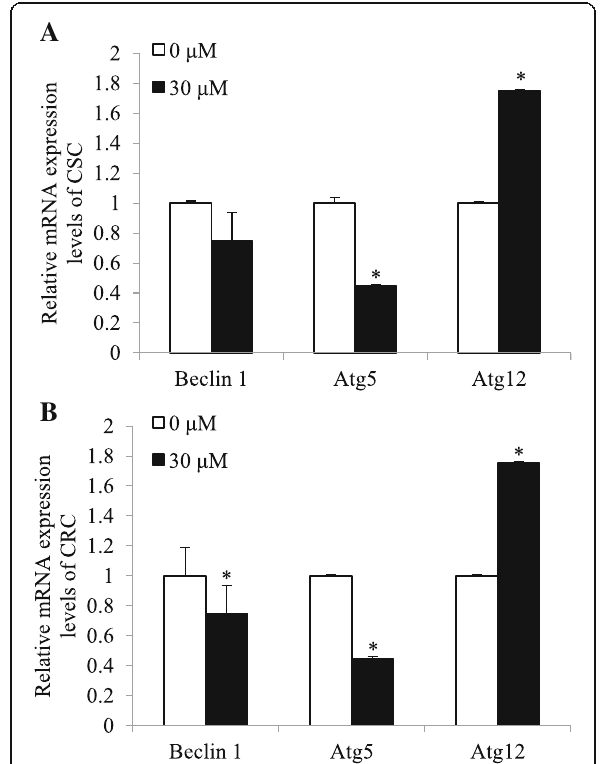
Fig. 2 Effects of cisplatin on mRNA expression levels of Beclin 1 , Atg5 , and Atg12 in CSC and CRC. After cells were exposed 30 μ M of cisplatin for 24 h, mRNA expression levels of ( a ). Beclin 1 , Atg5 , and Atg12 in CSC and ( b ). Beclin 1 , Atg5 , and Atg12 in CRC were quantified by qPCR. All mRNA expression levels were normalized against TBP . Each value is the mean ± SD. p < 0.05 was taken to define statistical significance. One-way ANOVA followed by Duncan post hoc